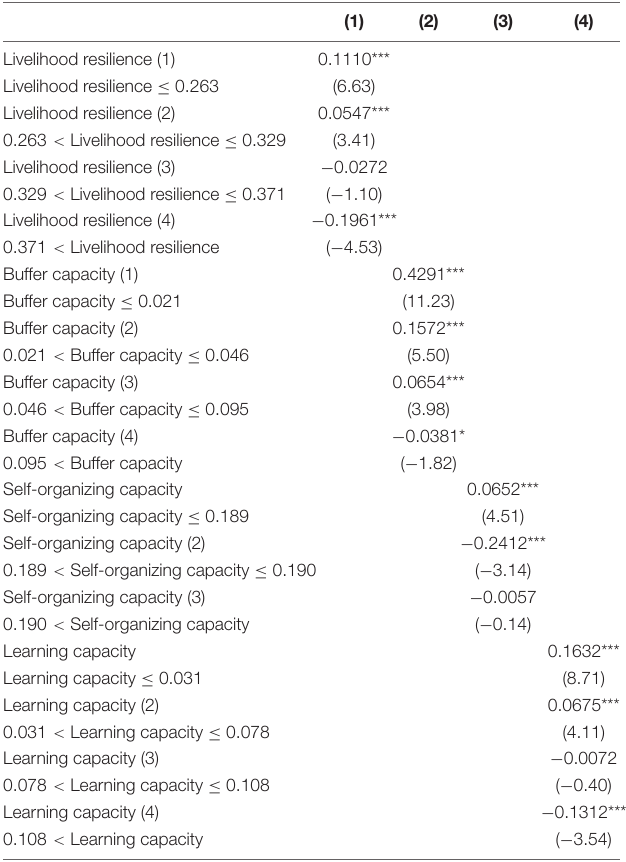
TABLE 7 | Parameter estimation results of the